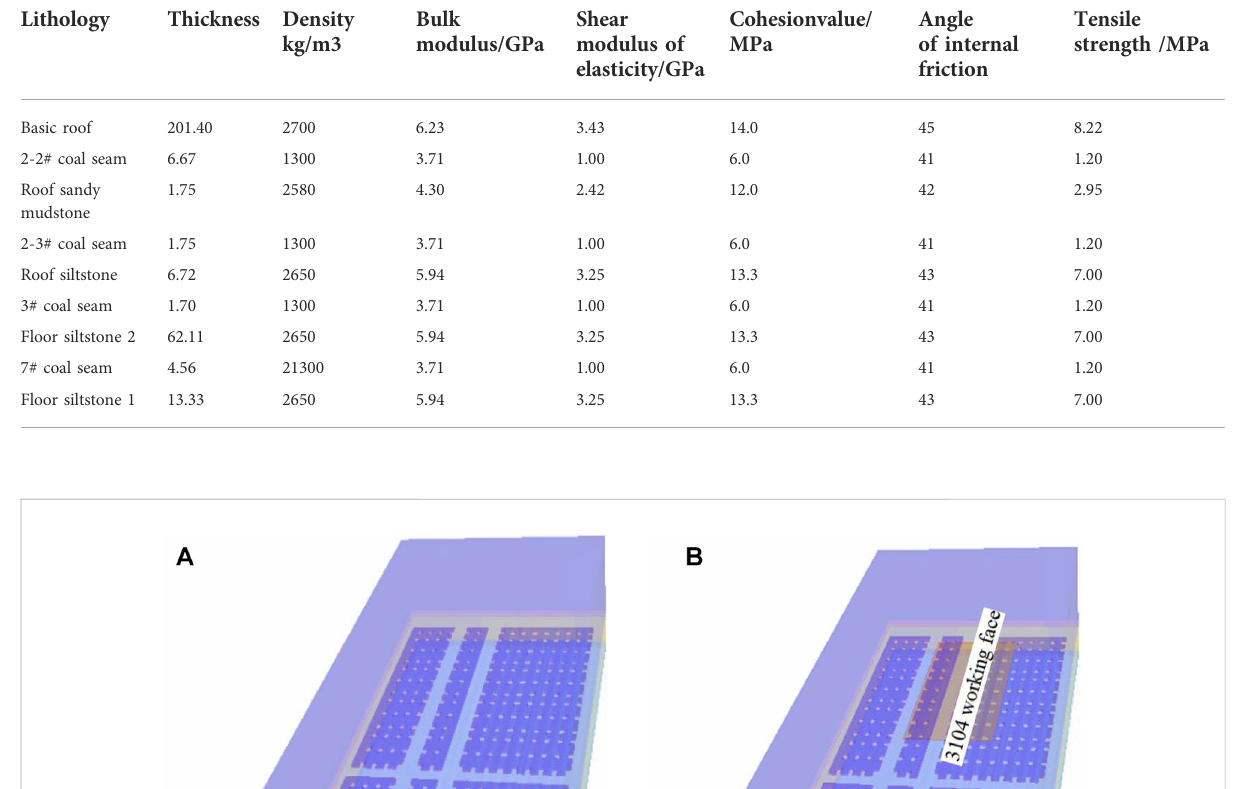
TABLE 1 Mechanical parameters of model rock strata.